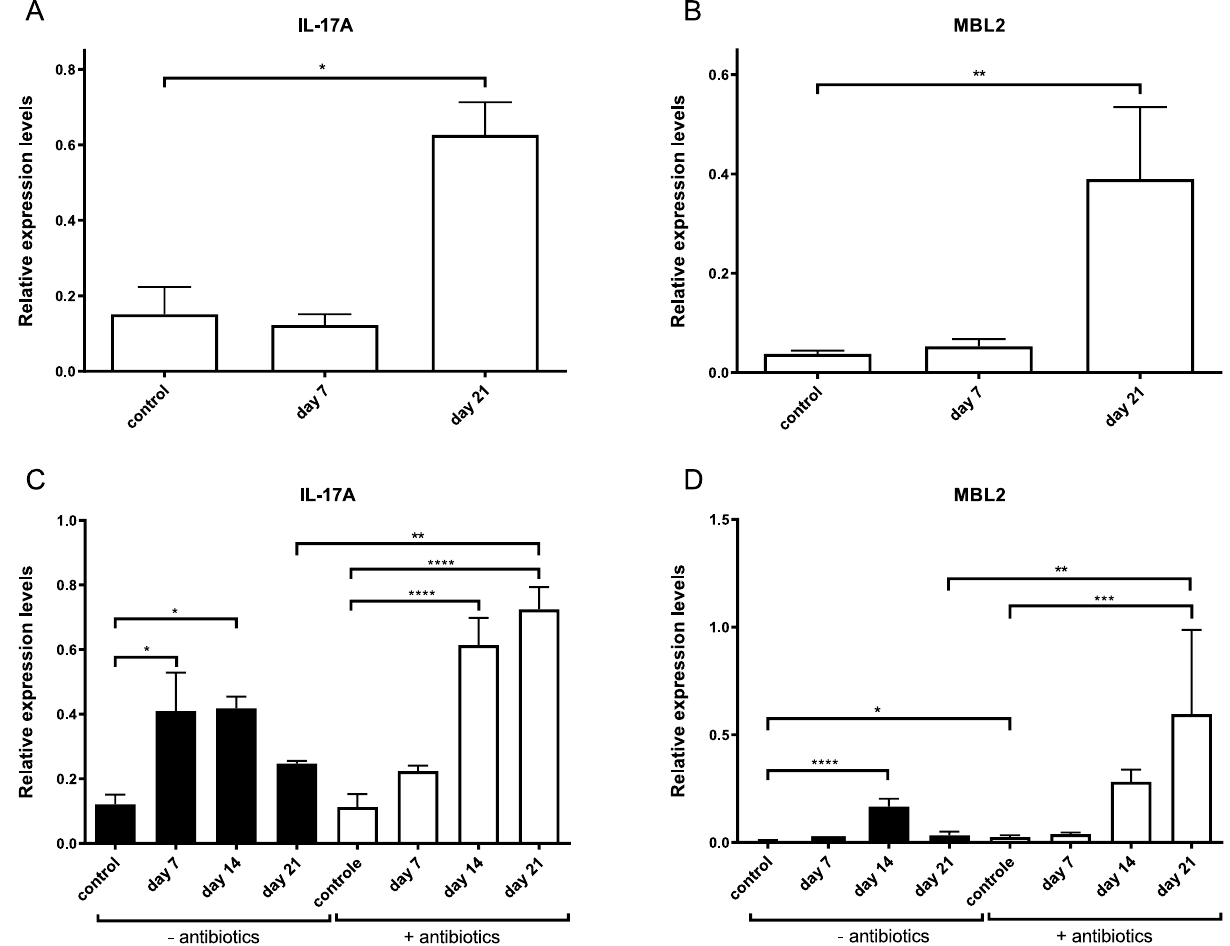
Figure 4. Kinetics of the intestinal IL-17A and MBL2 response following a G. duodenalis ( A , B ) and G. muris ( C , D ) infection in C75Bl/6 mice without (black bar) and with (white bar) antibiotic cocktail treatment. Relative mRNA expression levels were measured by qPCR at indicated time points. Mean transcription level from 5 mice are shown with SEM as error bars. (*p ≤ 0.05, **p ≤ 0.01, ***p ≤ 0.001, ****p ≤